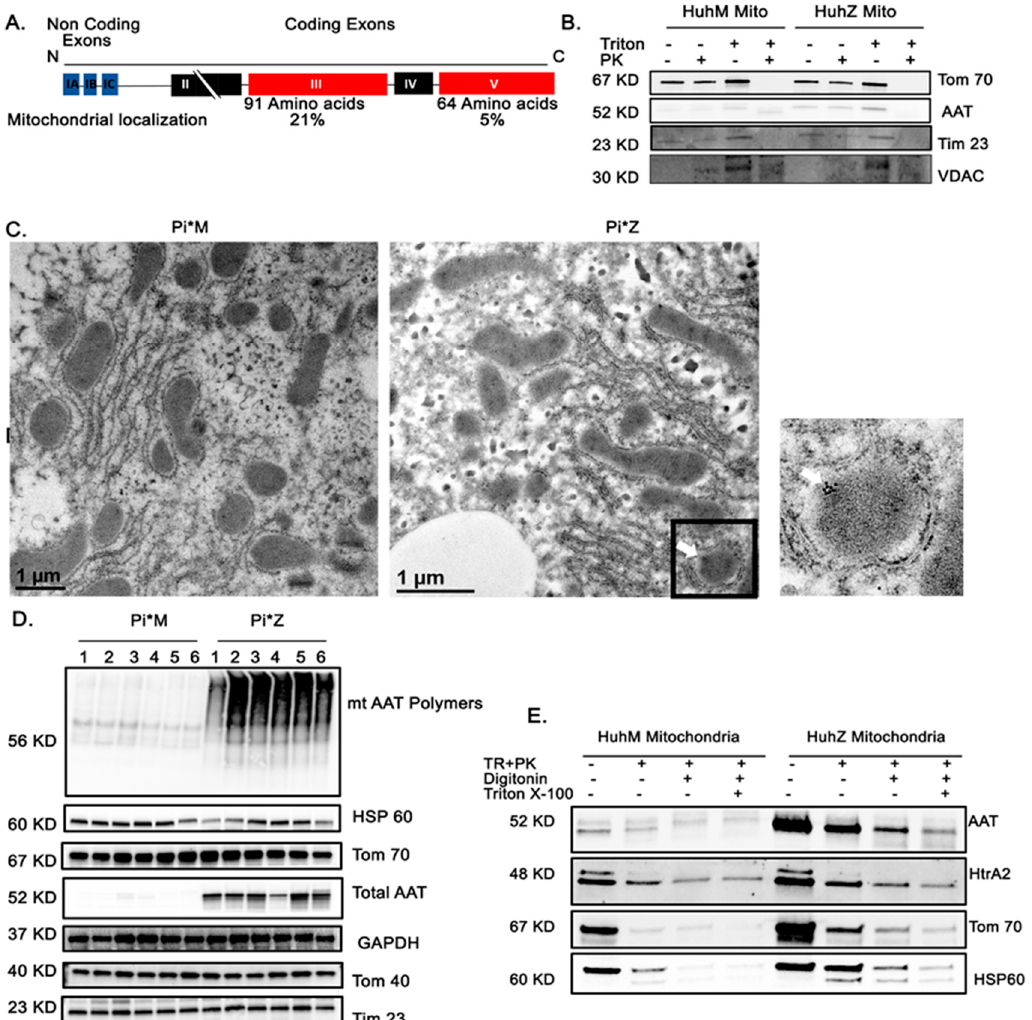
Figure 5. AAT association with hepatocyte mitochondria. ( A ) Alignment of the sequences of amino acids in the AAT molecule. ( B ) Western blot analysis showing sequential Triton and proteinase K treatments of the mitochondrial fraction of MAAT- and ZAAT-expressing Huh7.5 cells. A voltage-dependent anion-selective channel (VDAC) was loaded as mitochondrial loading control. ( C ) Immuno-electron microscopy results determining the morphology and localization of the mitochondria in the liver tissue from Pi*M and Pi*Z transgenic mice. Immunogold-labeled antibody against hAAT was used to detect mitochondrial hAAT (white arrow). ER entrapped between lipid droplets and mitochondria is indicated by the black arrow. ( D ) Native, non-denaturing Western blot analysis of hepatic mitochondrial ZAAT aggregates in the 6 Pi*M (1–6) and 6 Pi*Z (1–6) mouse liver tissue as well as the total levels of AAT, mitochondrial markers, and GAPDH as loading control. ( E ) Western blot analysis of isolated mitochondrial fraction of Huh7.5 cells, showing the exact localization of AAT in permeabilized mitochondria using proteinase K, digitonin, and Triton X-100.